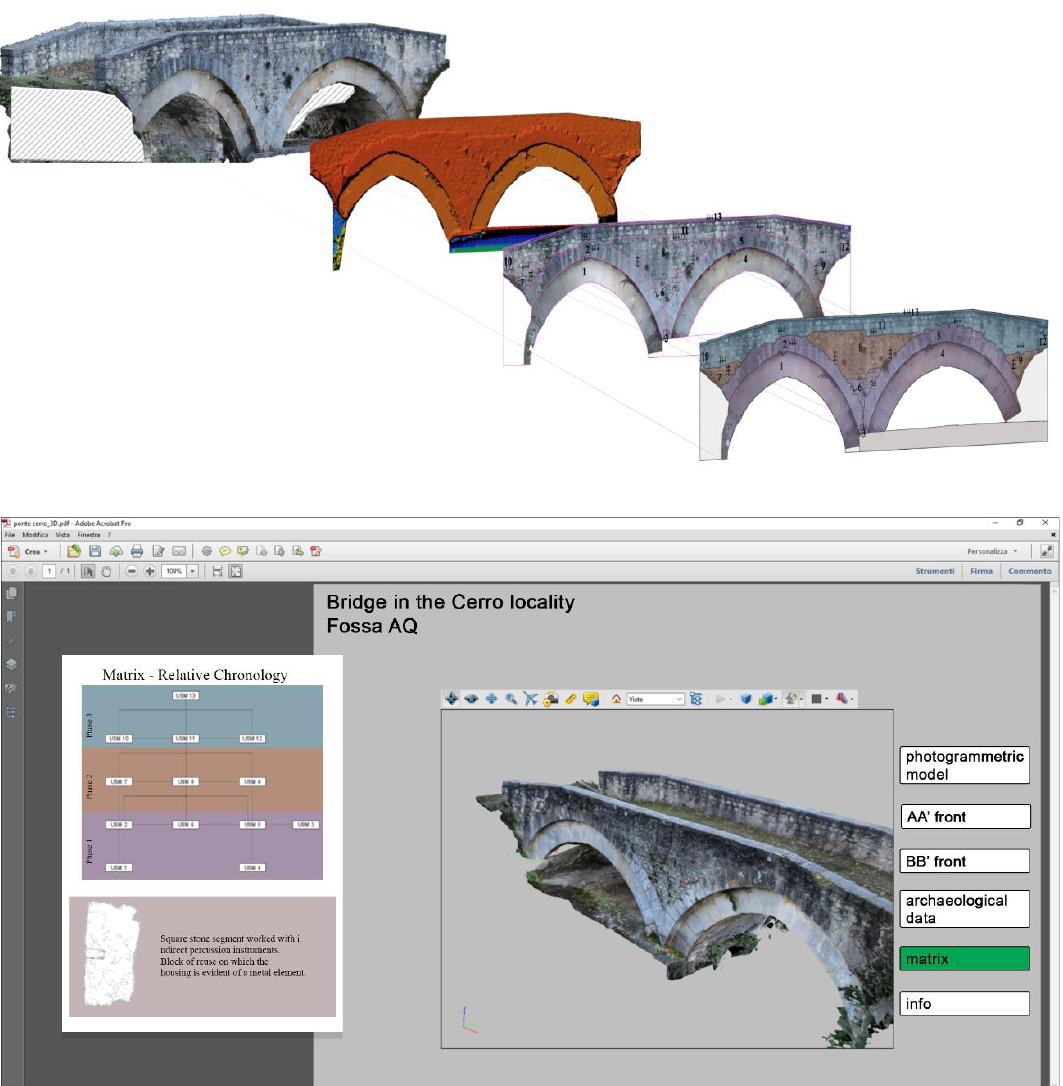
Figure 13. Photogrammetric bridge model mapped with the thematic results of the stratigraphic analysis.